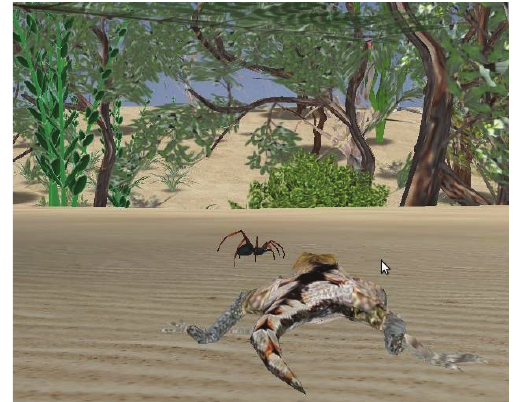
Figure 7: Lizard approaching a prey (spider).